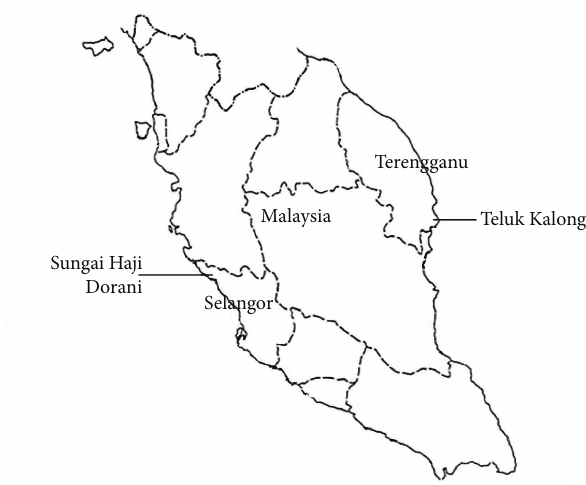
Figure 3: Maps of Peninsular Malaysia showings location of Teluk Kalong and Sungai Haji